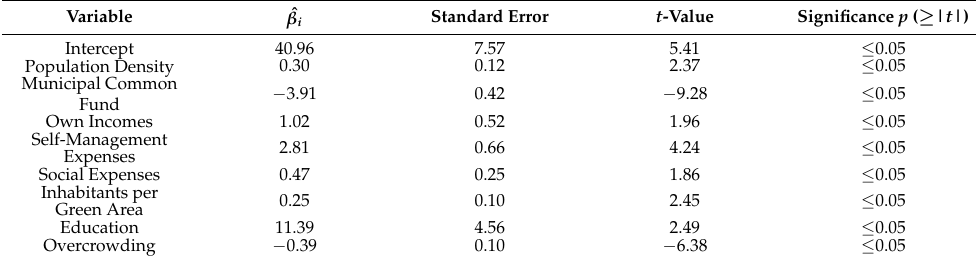
Table 7. Parameters from multivariate